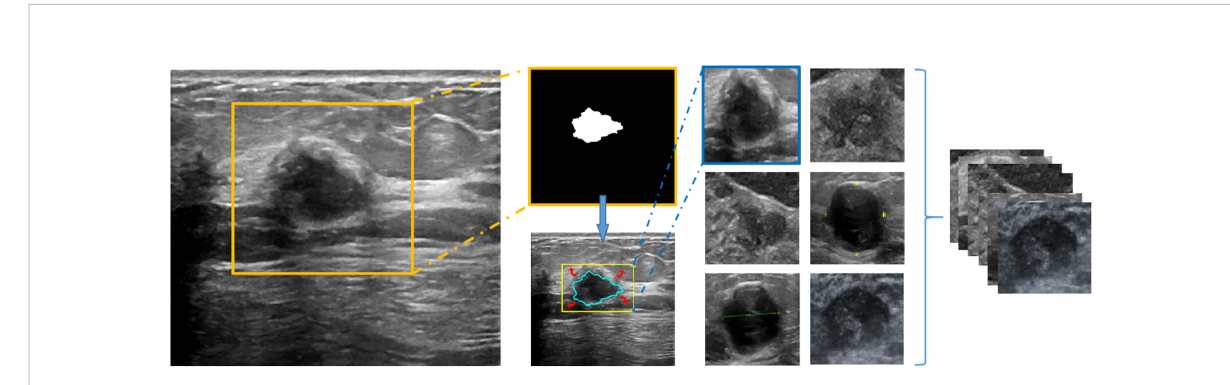
FIGURE 2 The working window of deep learning – based AI automatic classi fi cation system (the overall process of image